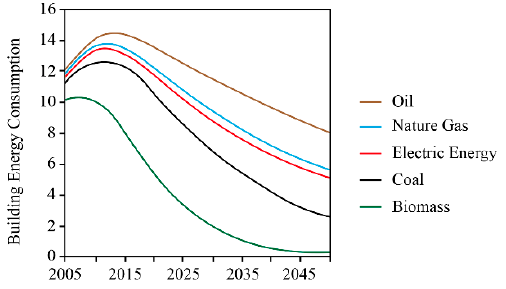
Figure 1. Energy type and consumption of rural residential buildings in cold regions.